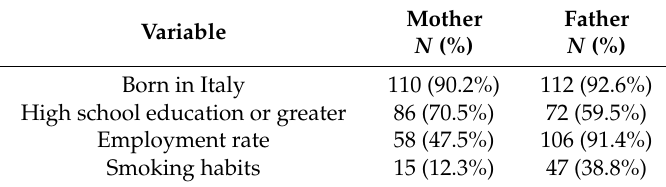
Table 5. Prevalence of variables regarding parents of children included in the IMP.AIR study.